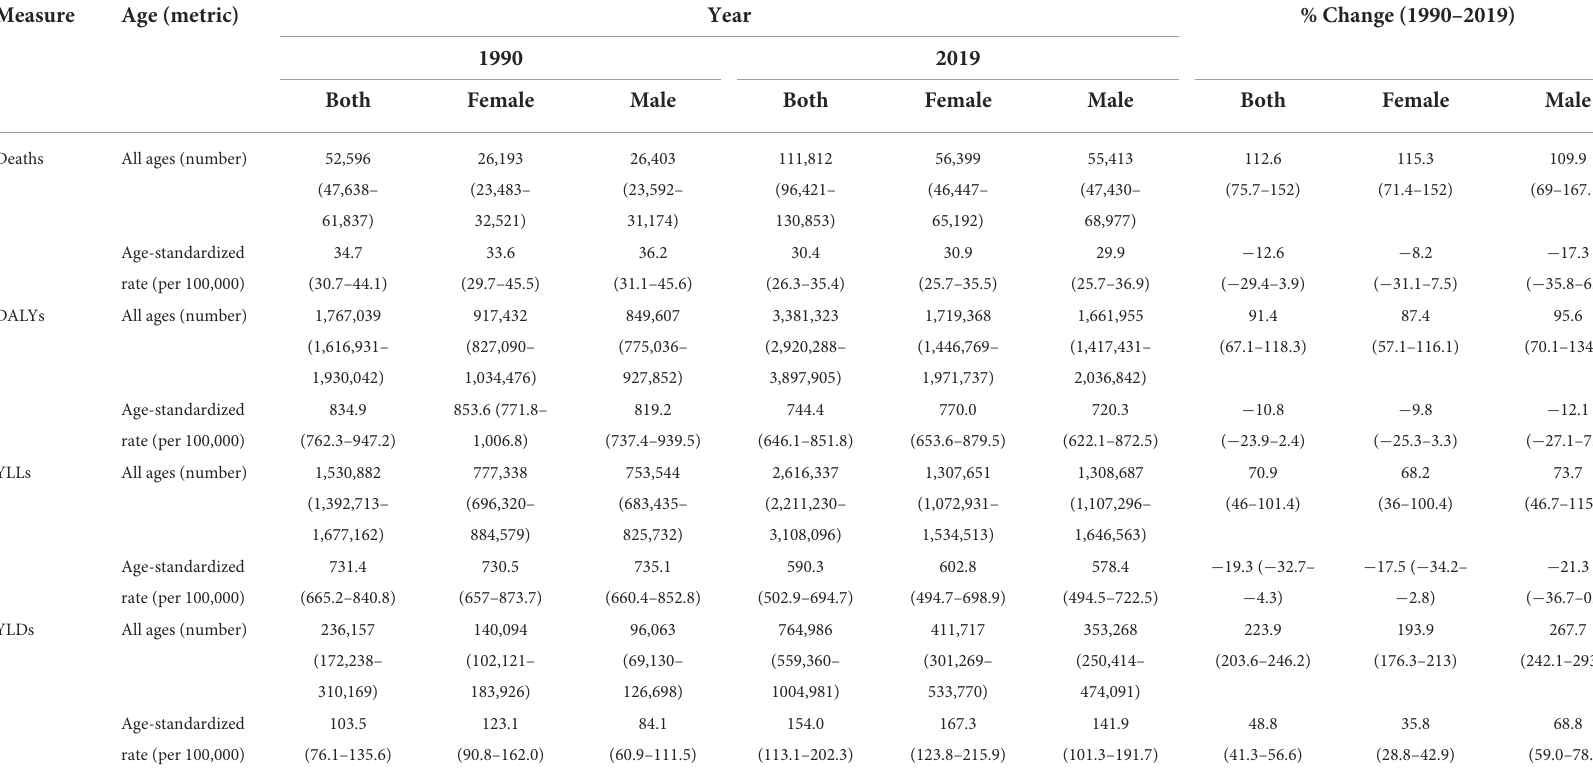
TABLE 3 All ages number and age-standardized rate of health measures of attributed burden to CKD risk factors based on sex during 1990–2019 in NAME